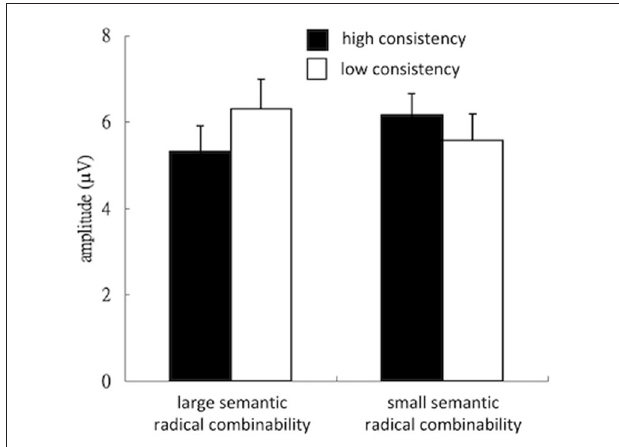
FIGURE 5 | Bar plots of the mean P200 response. HC, high consistency; LC, low consistency; LSC, large semantic radical combinability; SSC, small semantic radical